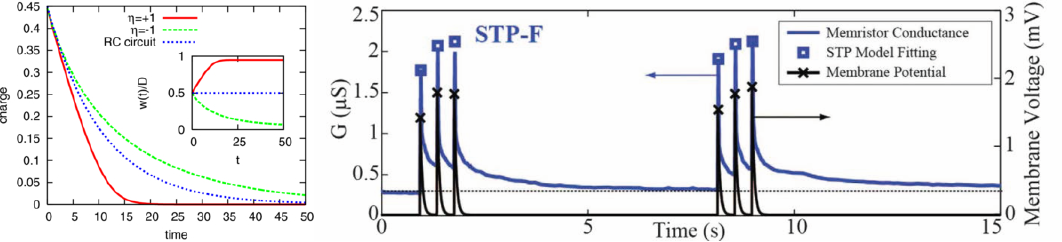
Figure 8. ( Left ): theoretical profile of Equation (35). ( Right ): experimental profile of short-term plasticity with TiO 2 . Both figures are reproduced with permission from [40] and [105], respectively. The limit of a normal RC circuit can be obtained from the above in the limit β lim β ∞ β W ( β − 1 G ( t )) = G ( t ) . The response of a memristor-capacitor and an RC circuit →